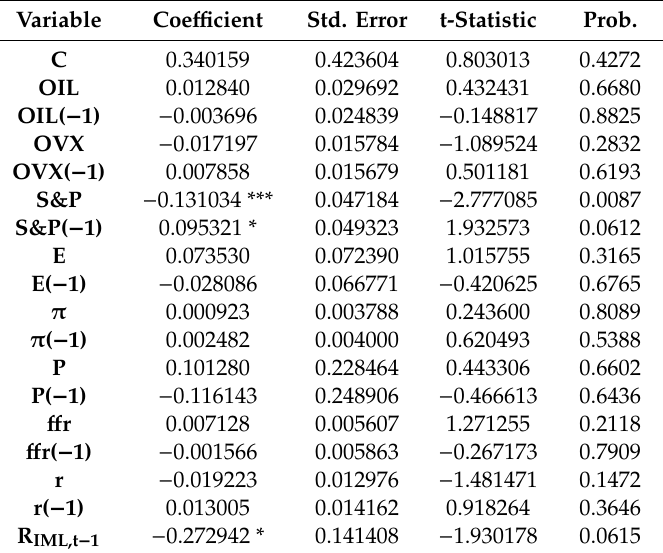
Table 18. Long-run ARDL model (financial